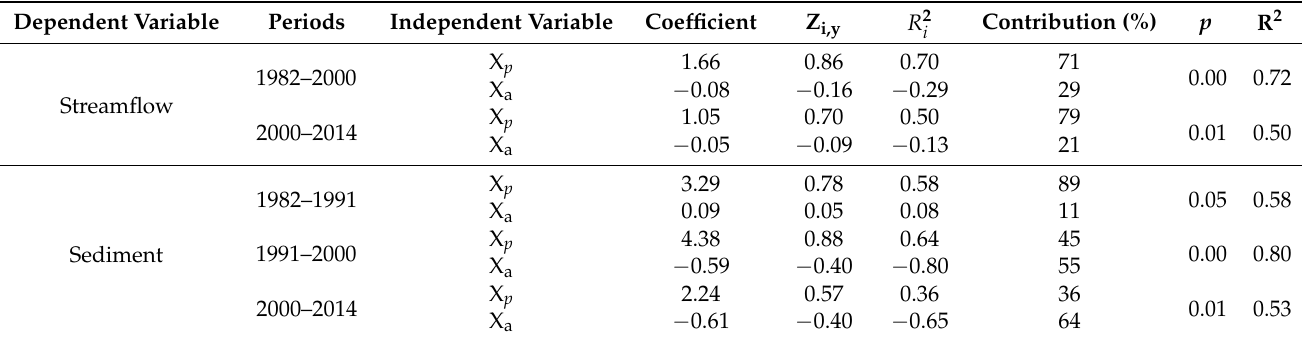
Table 2. Parameters of regression models and path analyses between observed streamflow, sediment, and influencing factors, respectively.